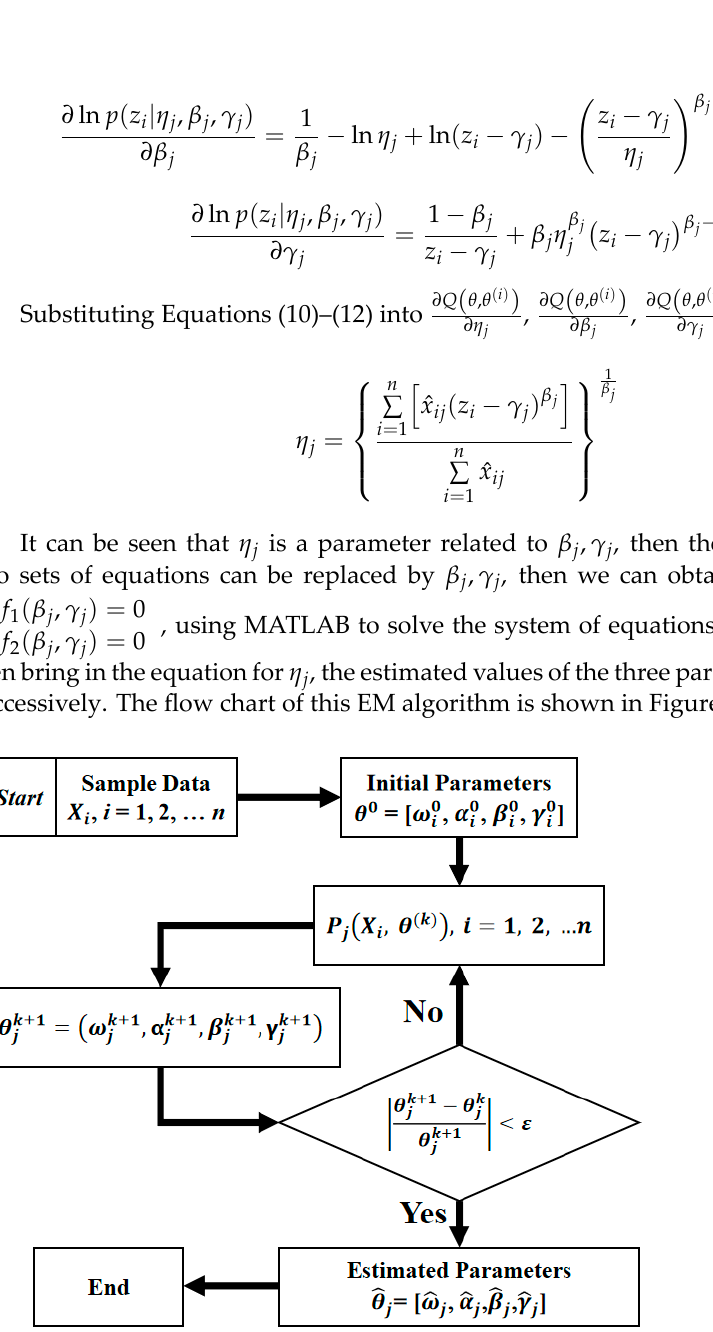
Figure 2. Flow chart of the EM